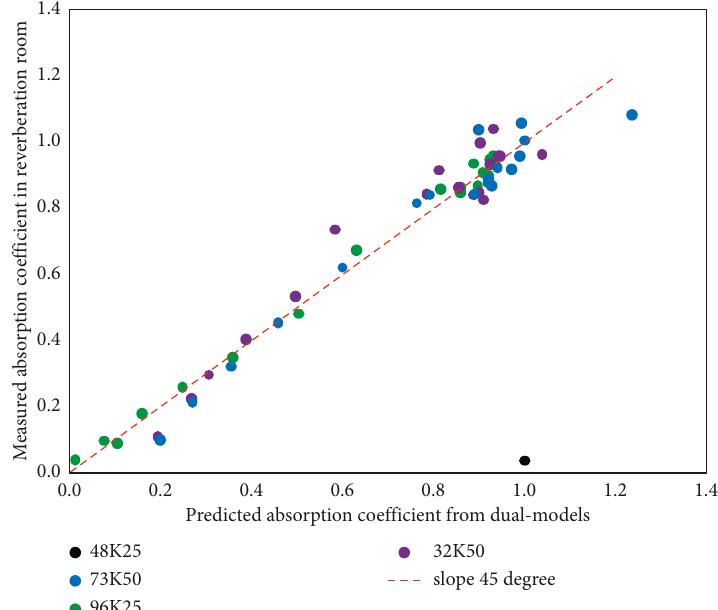
Figure 10: Scatter diagram of the estimated and measured sound absorption coefficients of four